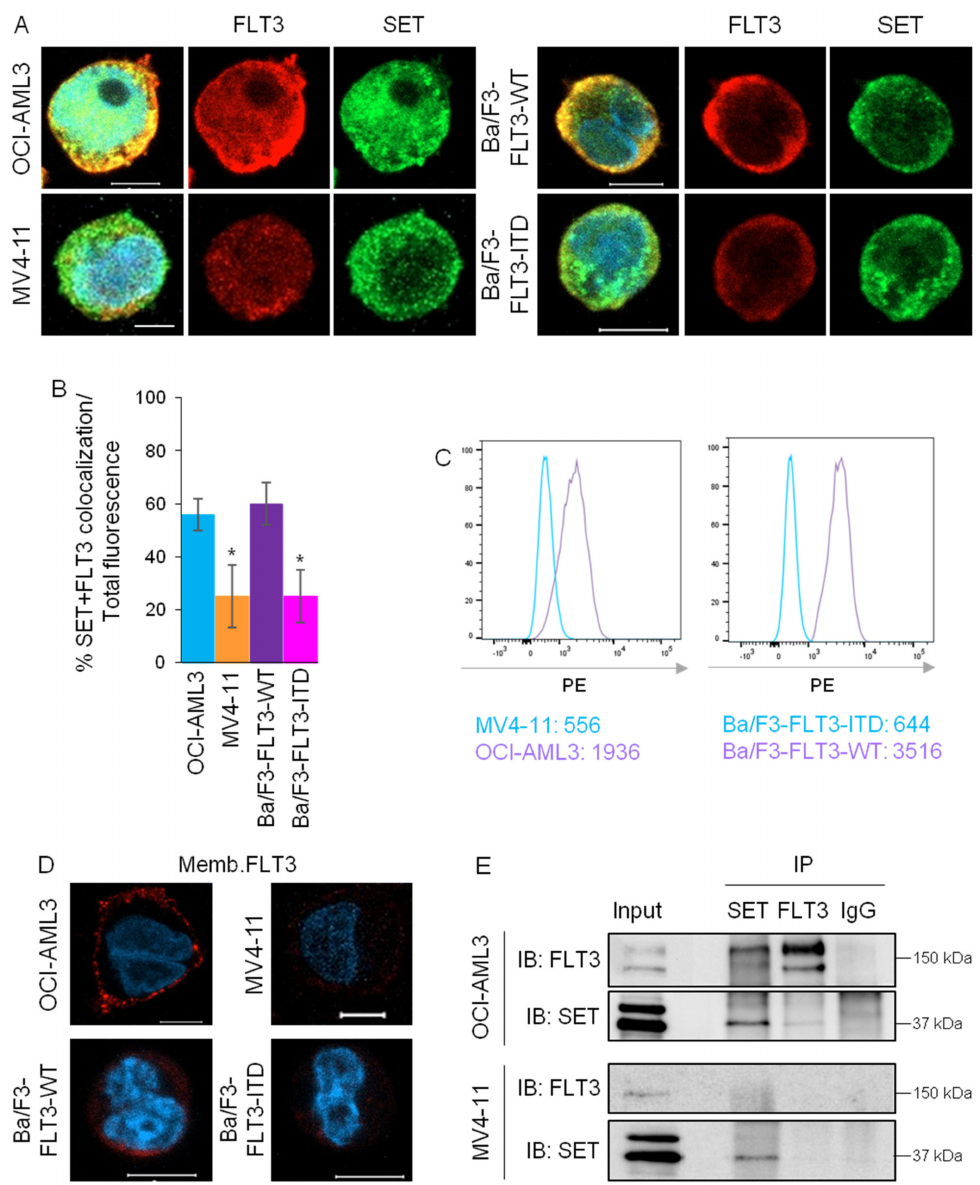
Figure 1. SET and FLT3 interact in FLT3-WT but not in FLT3-ITD AML cells. ( A ) Immunofluorescence of SET (green) and FLT3 (red) in AML cell lines OCI-AML3 (FLT3-WT) and MV4-11 (FLT3-ITD) and Ba/F3 cells overexpressing FLT3-WT or FLT3-ITD. Confocal microscopy showed co-localization (yellow) of both proteins in FLT3-WT cells and hardly in FLT3-ITD cells. Nuclei are stained with DAPI (blue). The scale bar represents 5 µ m. ( B ) Bar graphs representing quantification of mean values ± SD of SET and FLT3 co-localization referred to total cell volume, showing significantly less co-localization of SET/FLT3 in FLT3-ITD cells compared to FLT3-WT cells. ( C ) FACS analysis of membrane FLT3 in AML cells without permeabilization. FLT3-WT cells have more surface FLT3 compared to FLT3-ITD cells. Numbers represent mean PE fluorescence intensity. Representative image from more than four experiments. ( D ) Fluorescence confocal microscopy of endogenous FLT3 (red) in cells without permeabilization, where FLT3 surface expression is demonstrated in FLT3-WT cells but barely in FLT3-ITD cells. Cell nuclei are stained with DAPI (blue). Scale bar represents 5 µ m ( E ) Immunoprecipitation of SET and FLT3 in AML cells and subsequent western blot analysis, showing protein-protein interaction between SET/FLT3. Representative WBs are shown. * p < 0.05 FLT3-ITD cells vs. FLT3-WT cells. The uncropped bolts are shown in Supplementary Materials File